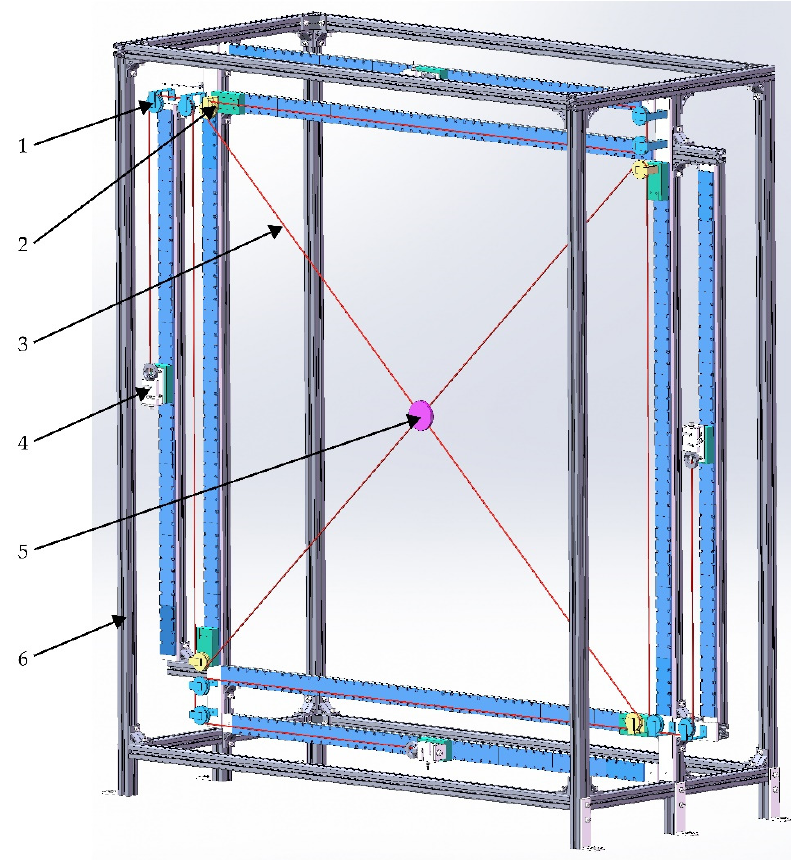
Figure 1. The four-cable-driven parallel mechanism with (1) a guide pulley mechanism (four groups), (2) a movable pulley mechanism (four groups), (3) a flexible cable (four pieces), (4) a linear motor (four groups), (5) a circular moving platform, and (6) a parallel mechanism frame.